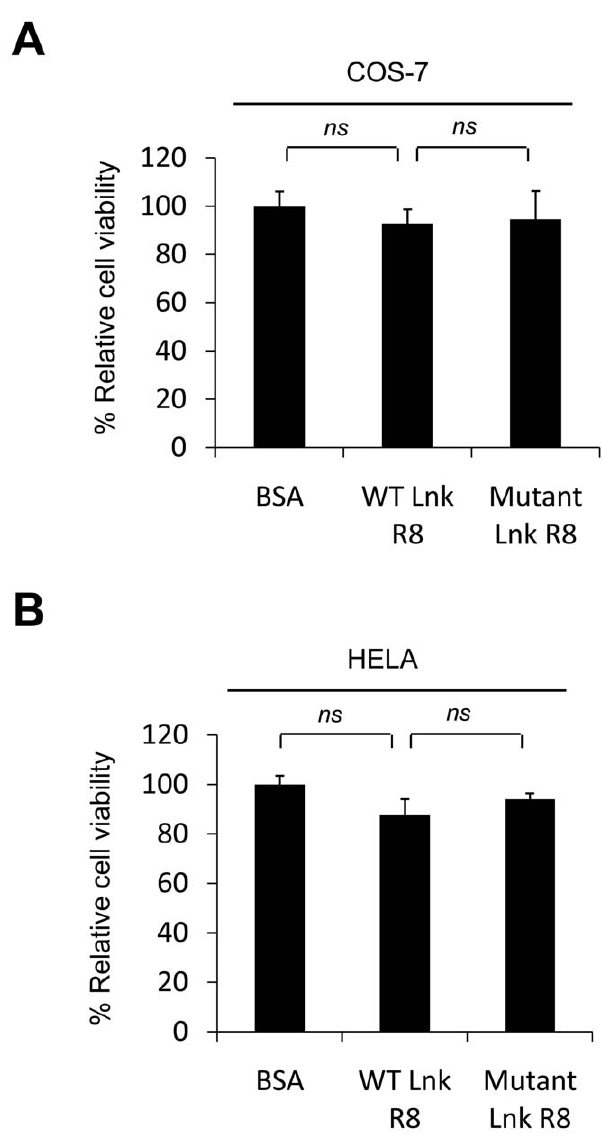
Figure 3. WT Lnk R8 delivery has no growth inhibition effect on non-hematopoietic COS-7 or HELA cells. (A) COS-7 or (B) HELA cell viability was measured by performing MTT assays at 48 hours after protein treatment. ( n.s. : not significant).